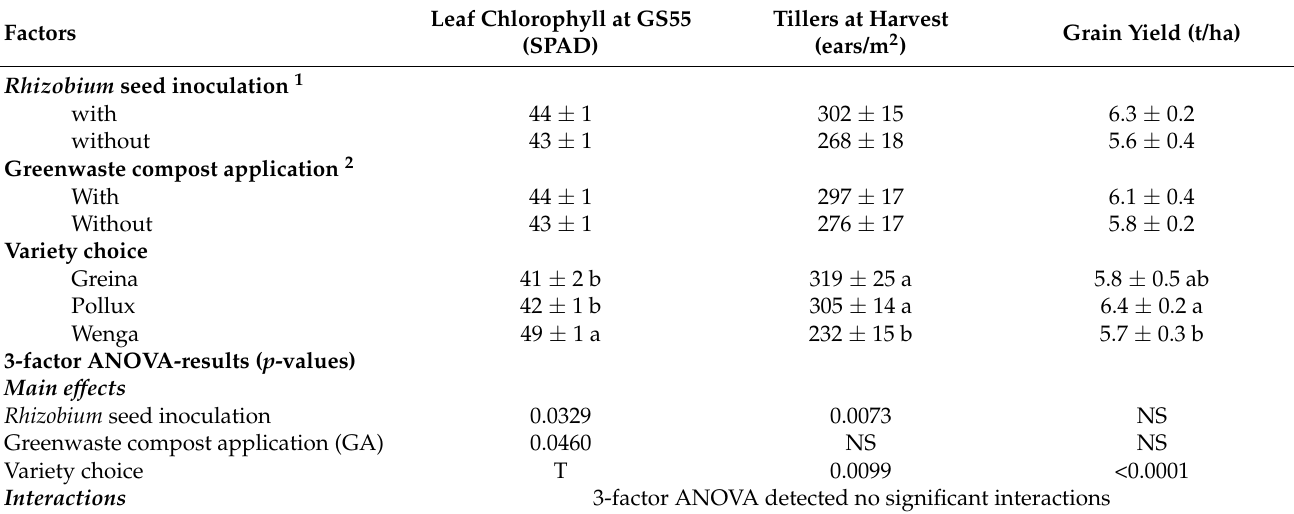
Table 6. Effect of clover ley management ( Rhizobium inoculation of clover seed and greenwaste compost applications) on performance parameters (estimated leaf chlorophyll levels at growth stage 55, tiller numbers at harvest, grain yield) in contrasting winter wheat varieties established after two-year clover leys. Values shown are main effect means ± SE.